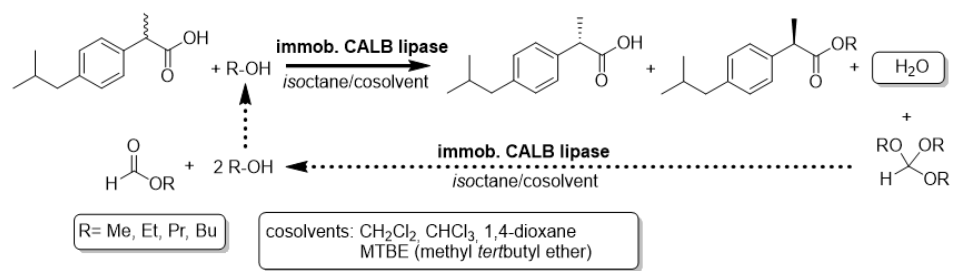
Figure 3. Schematic representation of the irreversible biocatalysed esterification of racemic ibuprofen with orthoformates.